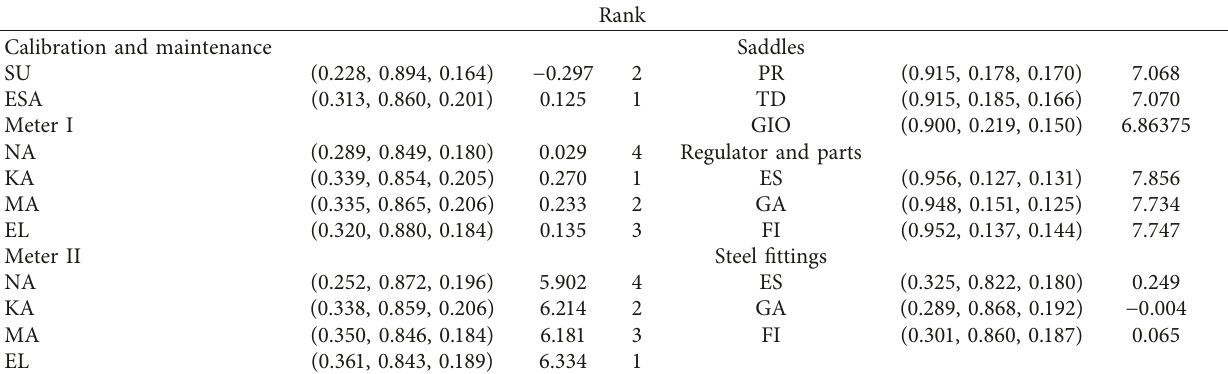
Table 11: 􏽥 A j , a j , and final alternative score results corresponding varying item